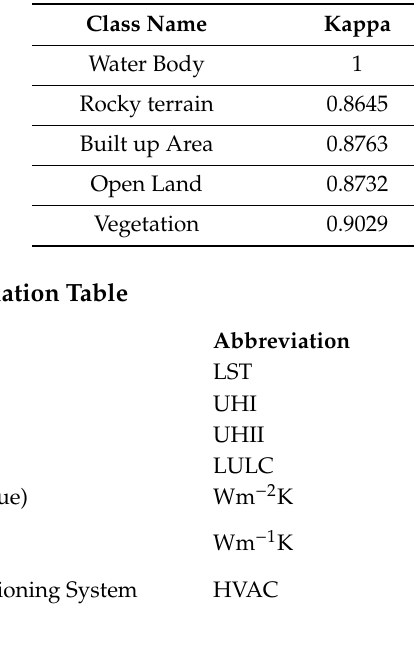
Table A2. Kappa statistics